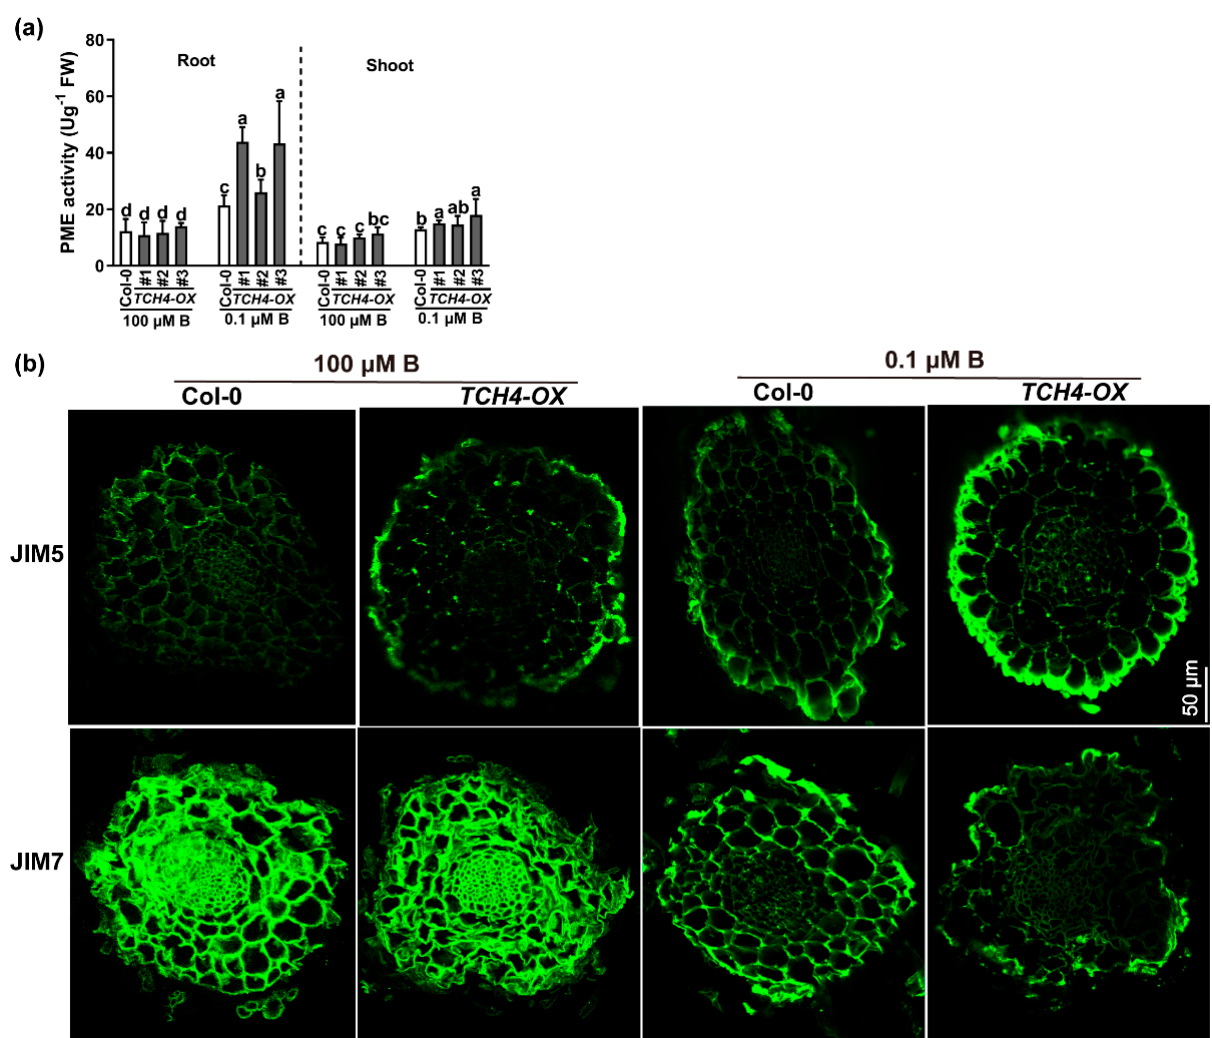
Figure 7. Differences in the degree of pectin methylesterification between Col-0 and TCH4 - OX plants. ( a ) Differences in PME enzyme activities between Col-0 and TCH4 - OX plants (means ± s.d., n = 5). ( b ) Immunohistochemical analysis in root cross-sections of Col-0 and TCH4 - OX plants. Scale bar, 50 µ m. The different letters above the columns indicate significant differences between all genotypes and all growth conditions ( p ≤ 0.05).